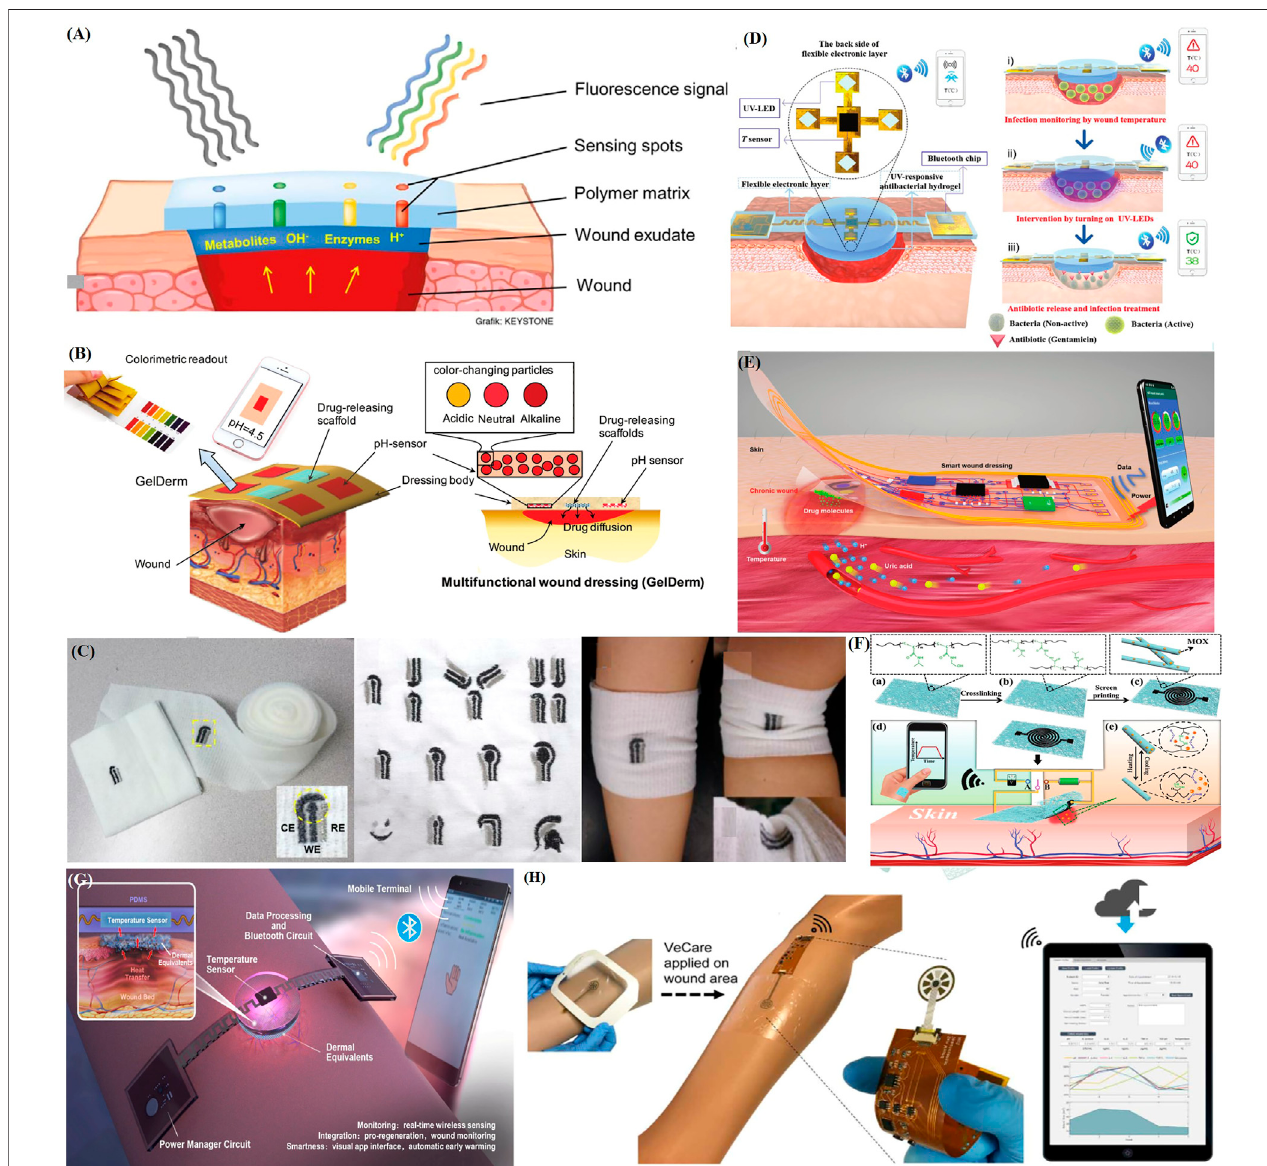
FIGURE 4 | Recent applications of representative intelligent wearable sensors for wound healing. (A) Schematic diagram of a fl uorescence sensing system with glucoseconcentrationandpHdetection(Jankowskaetal.,2017). (B) Schematicdiagramofanintelligenthydrogeldressing(GelDerm)withpHsensitiveanddrugeluting components for treatment of epidermal wounds (Mirani et al., 2017). (C) An electrochemical sensor fabricated on gauze, a wound dressing produced via embroidery, and examples of their application to an elbow (Liu and Lillehoj, 2017). (D) Intelligent electronic temperature sensing dressing composition and principle schematic diagram (Pang et al., 2020). (E) Schematic diagram of a battery-free wireless wound dressing for wound infection monitoring and electronically controlled on-demand wound-site drug delivery (Xu et al., 2021). (F) Flow chart showing the preparation of a fl exible, breathable skin-based electronic device with temperature sensing capabilities and temperature-based on-demand drug release (Gong et al., 2019). (G) Schematic diagram of the structure and sensing principle of a fl exible wound healing system (FWHS) (Lou et al., 2020). (H) Schematic diagram of a fl exible micro fl uidic multi-immunosensor platform for chronic wound monitoring; a built-in fl exible printed circuit board (FPCB) is connected to a wireless portable analyzer and external mobile applications that can be used for patient fi les, medical records, data records, and data analysis (Gao et al., 2021).